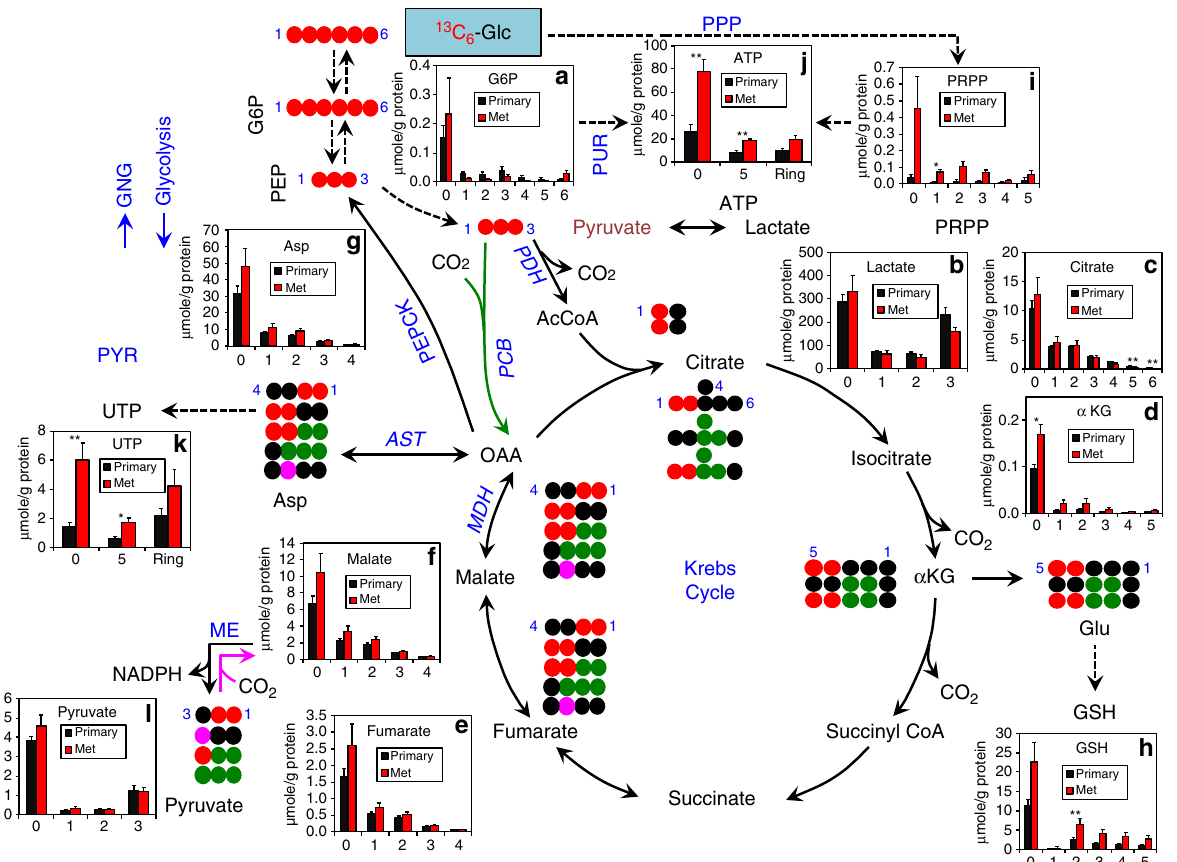
Fig. 4 Lymph node metastases show enhanced PPP and biosynthesis of glutathione and nucleotides relative to the matched primary PDTX in the same mouse. Mice bearing F2 primary PDTX and metastatic lymph node lesions (Met) (from patient UK025) were fed the 13 C 6 -Glc enriched liquid diet for 18 h (cf. Fig. 1) before necropsy. Tissues were processed and analyzed by IC-UHR-FTMS, as described in Fig. 3. Glucose- 13 C is traced through glycolysis, gluconeogenesis ( GNG ), PPP, the Krebs cycle, ME reactions, and synthetic pathways of GSH, purine nucleotides ( PUR ), and pyrimidine nucleotides ( PYR ). Not all possible labeled metabolites were shown. a – l µ mole/g protein content of isotopologues of glucose-6-phosphate (G6P), lactate, citrate, α KG, fumarate, malate, Asp, GSH, phosphoribosyl pyrophosphate (PRPP), ATP, UTP, and pyruvate, respectively in primary tumor versus lymph node metastases (cf. Supplementary Fig. 11 for the fractional distribution of these isotopologues). The x -axis represents the number of 13 C atoms present in each compound; for ATP and UTP, “ ring ” is the summed value for the 13 C 6 to 13 C 9 isotopologues. All other abbreviations and symbols are as in Fig. 3. Values shown are mean ± SEM ( n = 5). * 0.01 < P < 0.05; ** 0.001 < P < 0.01; *** P < 0.001, two-tailed t -test (see Methods) (4) elevated ME activity in the reverse direction (higher fractional 2B (BAsT) cells (gift of Dr Y. Fondufe-Mittendorf, University of enrichment of 13 C 1 -isotopologues of malate, fumarate, succinate, and Asp); (5) utilization of non-tumor derived 13 C- α KG (e.g., from hepatic 13 C-Gln) for Glu synthesis (total 13 C fractional glucose metabolism of the same cells in vitro versus in vivo. After enrichment of Glu i was higher than that of its precursor α KG (Fig. 5e); (6) more favorable non-oxidative PPP ( 13 C scrambling in the PPP intermediate S7P (Fig. 5l) was much more extensive). Except for (3), the rest of the metabolic features were akin to those of the PDTXs when compared with the ex vivo tissue counterparts (cf. Fig. 3, Supplementary Fig. 7a). Supplementary Fig. 7b and 5 compare the central metabolic activity of BAsT cells as tumor xenograft versus in vitro monolayer cultures. We found multiple distinct features of the BAsT tumor xenografts relative to cells in vitro, which were consistent with: (1) more active glycogen synthesis (higher abundance of 13 C-glycogen, (Supplementary Fig. 7b); (2) uptake of plasma glucose derived from hepatic gluconeogenesis (scrambled 13 C patterns of fructose-1,6-bisphosphate (F1,6BP, a , pyruvate b , and lactate c , Fig. 5); (3) enhanced PCB-initiated Krebs cycle activity (elevated fractional enrichment in the 13 C 3 - cycle metabolites (Glu/succinate/Asp) (Supplementary Fig. 7b) and 13 C 5 -isotopologues of citrate d as well as 13 C 3 - and 13 C 4 - and enhanced fractional enrichment of 13 C-labeled Krebs cycle isotopologues of Asp k , Malate h , fumarate g and succinate f , metabolites. Neither could they explain the distinct scrambled 13 C labeling patterns of F1,6BP ( 13 C Fig. 5) similar to the case of human NSCLC tumors in vivo; 2, 28 3 -isotopologue in particular, NATURE COMMUNICATIONS | 8: 1646 | DOI: 10.1038/s41467-017-01518-z |